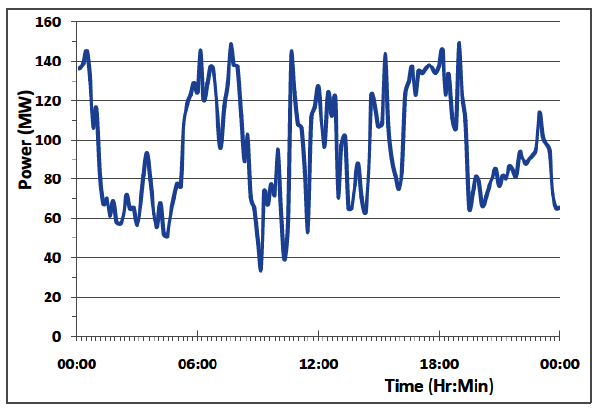
Figure 6. Typical summer time wind profile